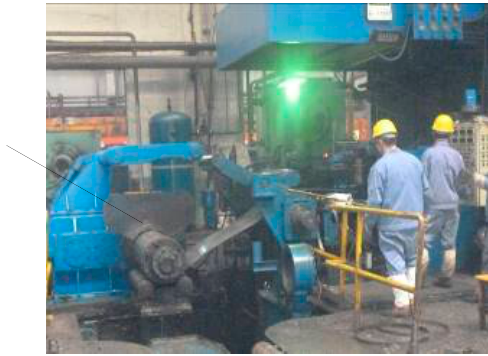
Figure 13. Test field.